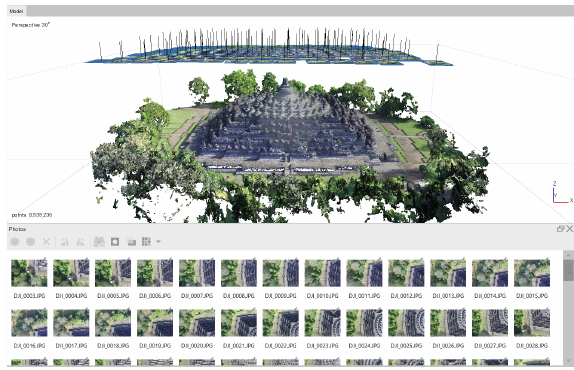
Figure 5. Example of the camera positions for acquiring the detailed point cloud of a focused area by means of photogrammetry.